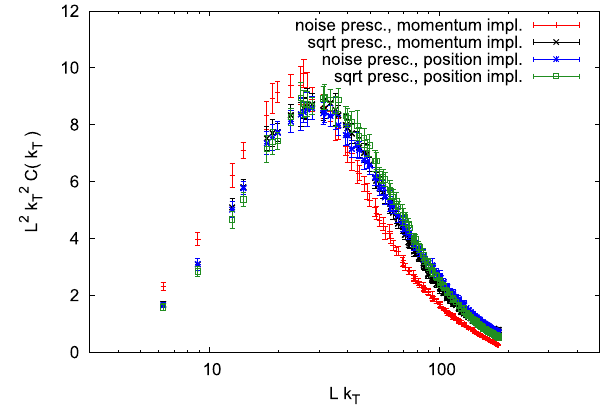
Fig. 4 Rescaleddimensiolnessgluondistributionsatrapidity s = 0 . 05 on a L / a = 64 lattice. We compare ’square root’ and noise prescrip- tions for the running coupling, both for position-space evolution and momentum-space evolution. All cases are evolved from the same initial